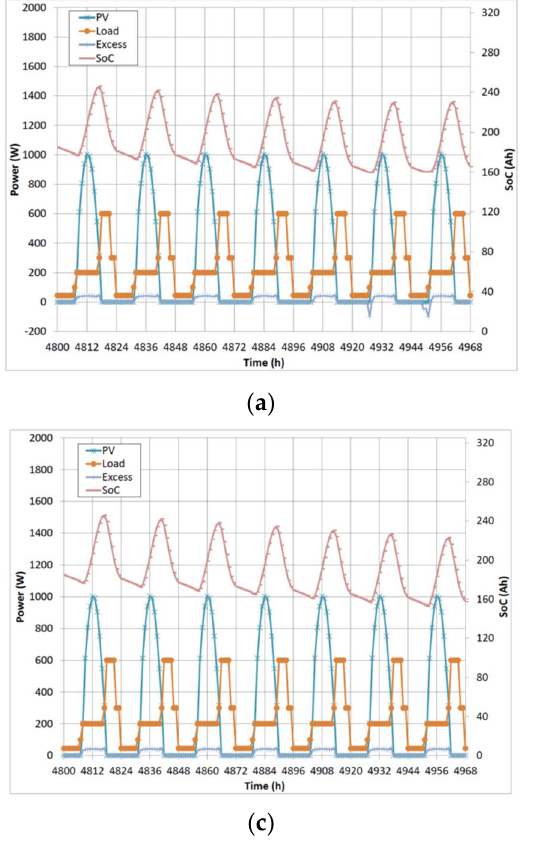
Figure 6. Typical analysis results in July: ( a , b ) with SoC 0.5 and ( c , d ) with SoC 0.4. Table 4. Summary of analysis results on average daily excess energy per month of the